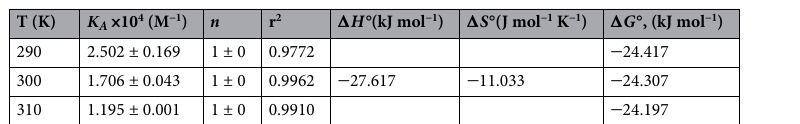
Table 3. Binding parameters including binding constant ( K A ), Hill coefficient constant ( n ), and the relative thermodynamic parameters (Gibbs free energy; (cid:31) G ◦ , enthalpy; (cid:31) H ◦ , and entropy; (cid:31) S ◦ ) for the interaction of BSA and 5A8HQ at 290, 300, and 310 K. r 2 is the squared correlation